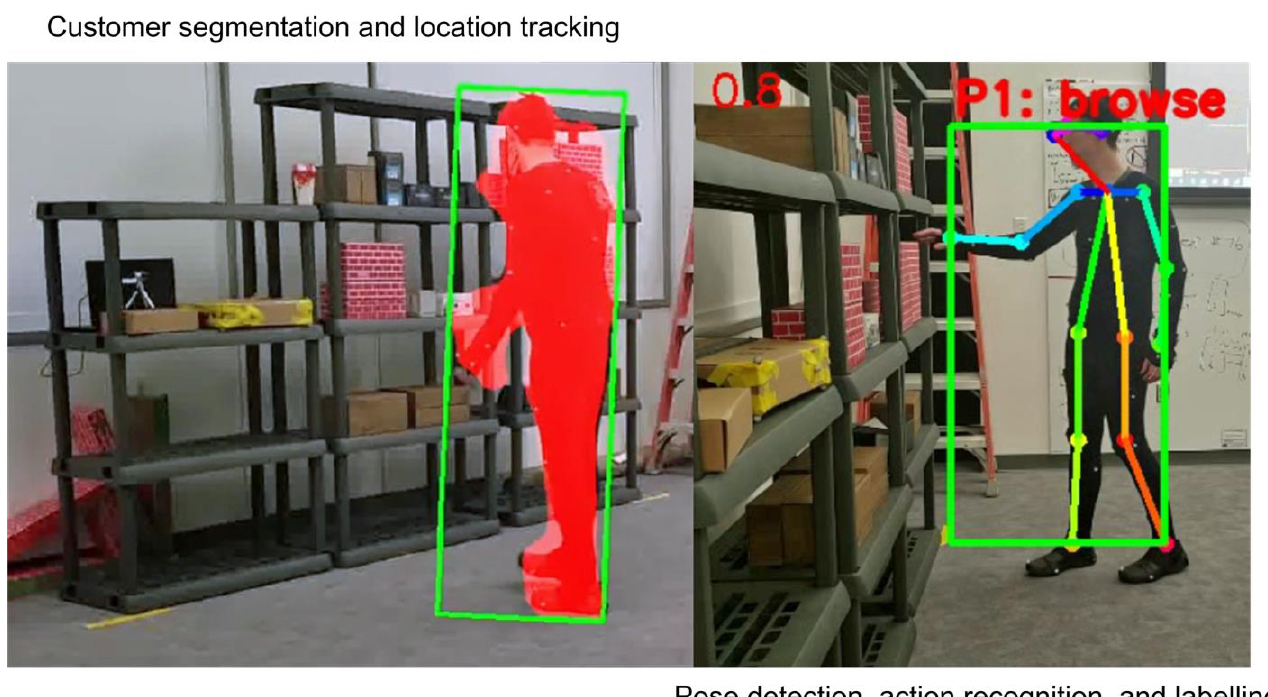
Figure 7. Our edge computing framework for customer identification and action recognition in-